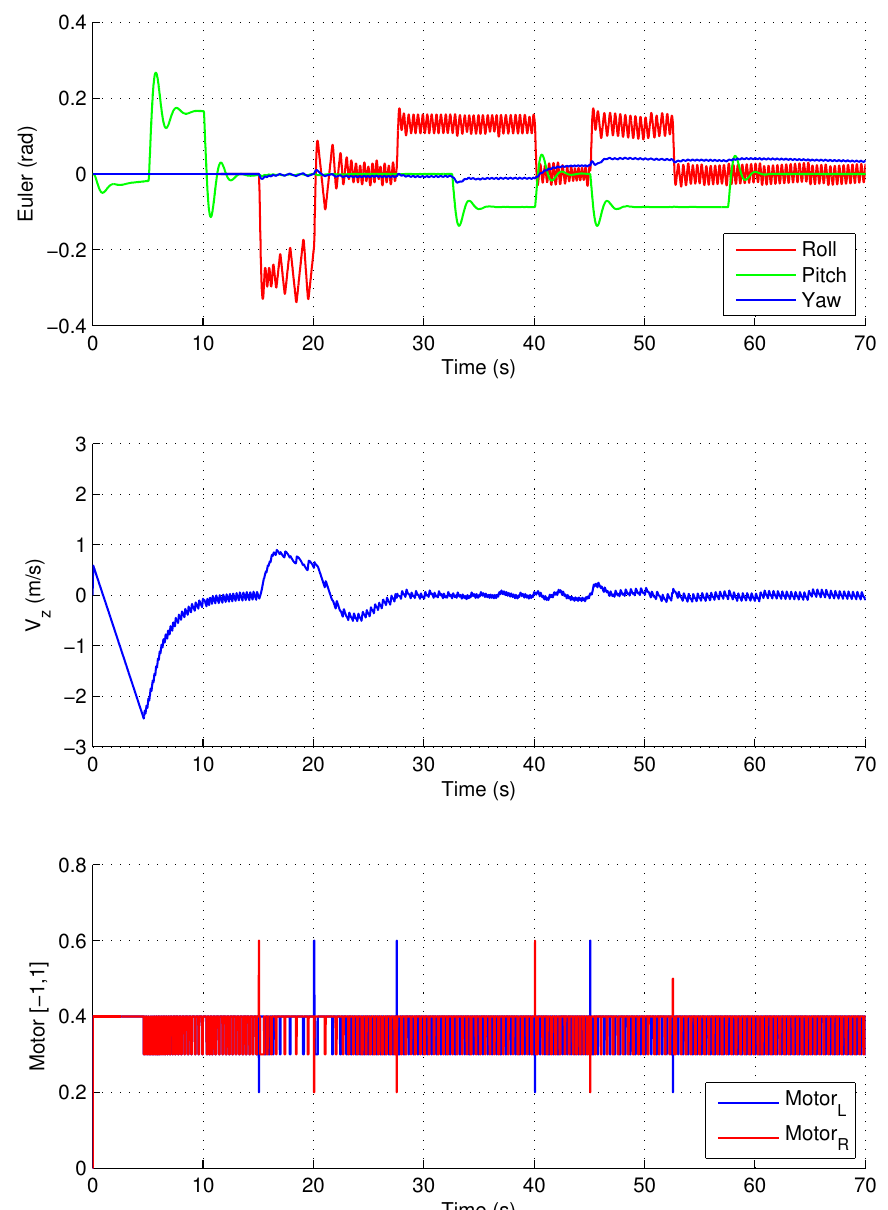
Figure 13. Evolution of V z and thrust signal against modifications in φ and θ